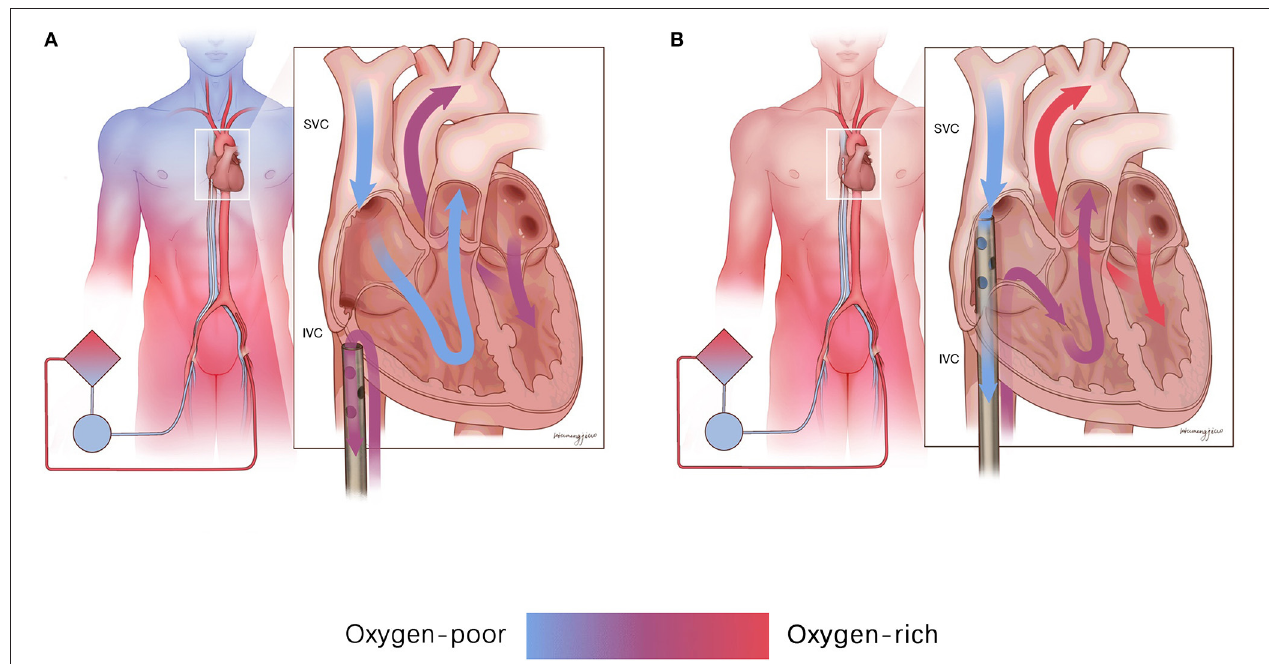
FIGURE 3 | The mechanism of drainage from the SVC improves upper body oxygenation. (A) Drainage from the SVC made the oxygen-rich blood from the IVC drain back to the ECMO circulation, and the oxygen-poor blood from the SVC enters the right atrium and restarts the self-circulation. (B) Drainage from the SVC could drain out the oxygen-poor blood from the SVC into the ECMO circulation, and the oxygen-rich blood from the IVC could enter the right atrium to participate in the self-circulation. IVC, inferior vena cava; SVC, superior vena